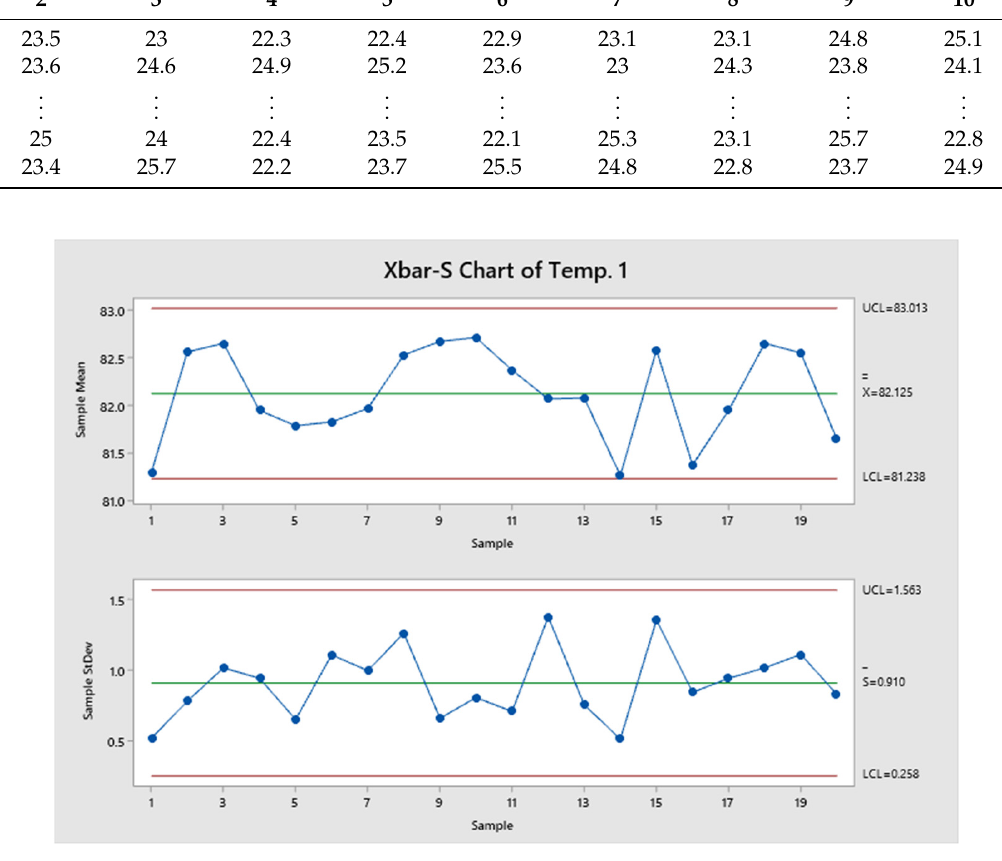
Figure 4. X-bar-S control chart for temperature. Table 3. Orthogonal Array (OA).